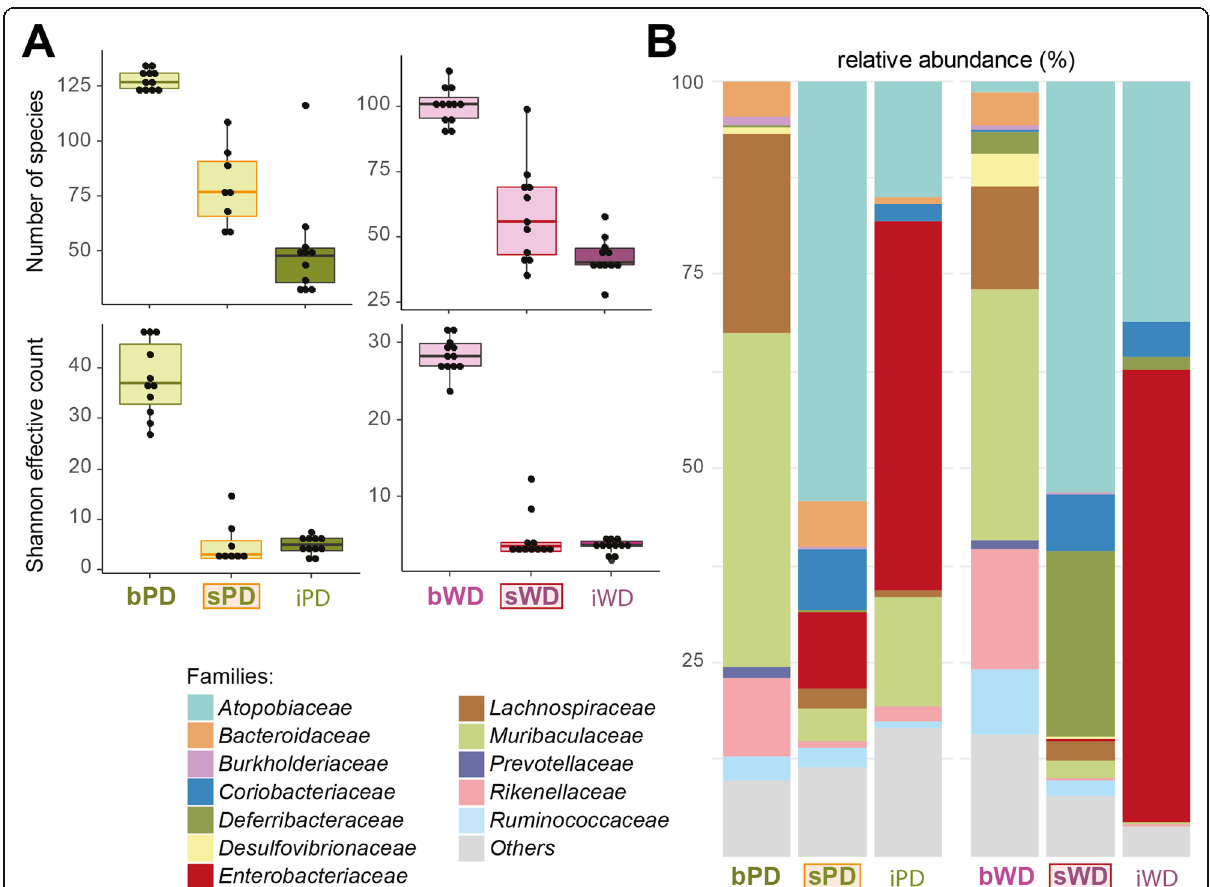
Fig. 3 Microbial shifts in mice following streptomycin treatment and infection. a α -diversity changes are shown as boxplots. N of WD fed, untreated mice = 12, n of WD fed, streptomycin-treated/infected mice = 11, n of PD fed, untreated/infected mice = 11, n of PD fed, streptomycin- treated mice = 8. b For both PD or WD fed mice after streptomycin application and infection with S. Typhimurium, an overview of cumulative relative abundances of all dominant families are displayed. See legend of Fig. 1c for statistical